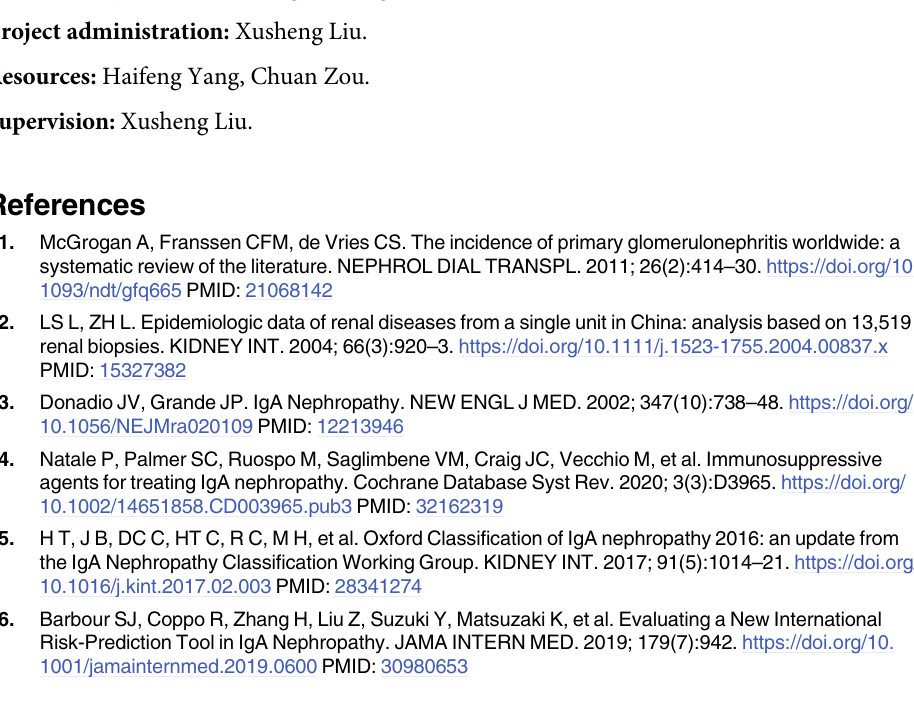
S1 Table. Features included demographic, clinical, laboratory data and treatment of the IgAN